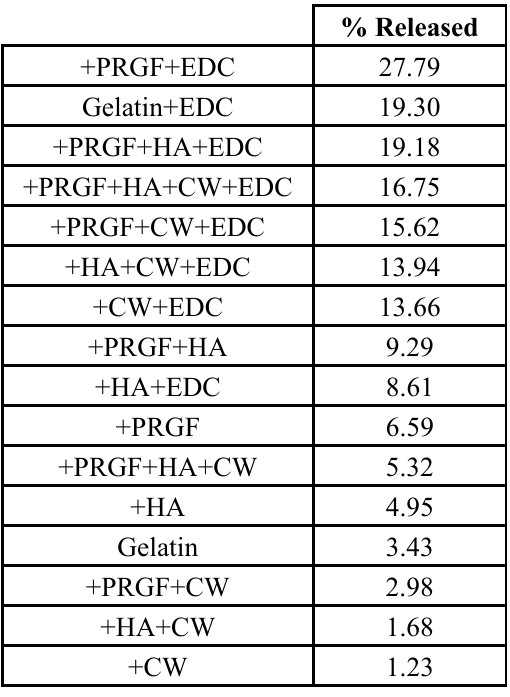
Table 3. Percent total protein released after 90